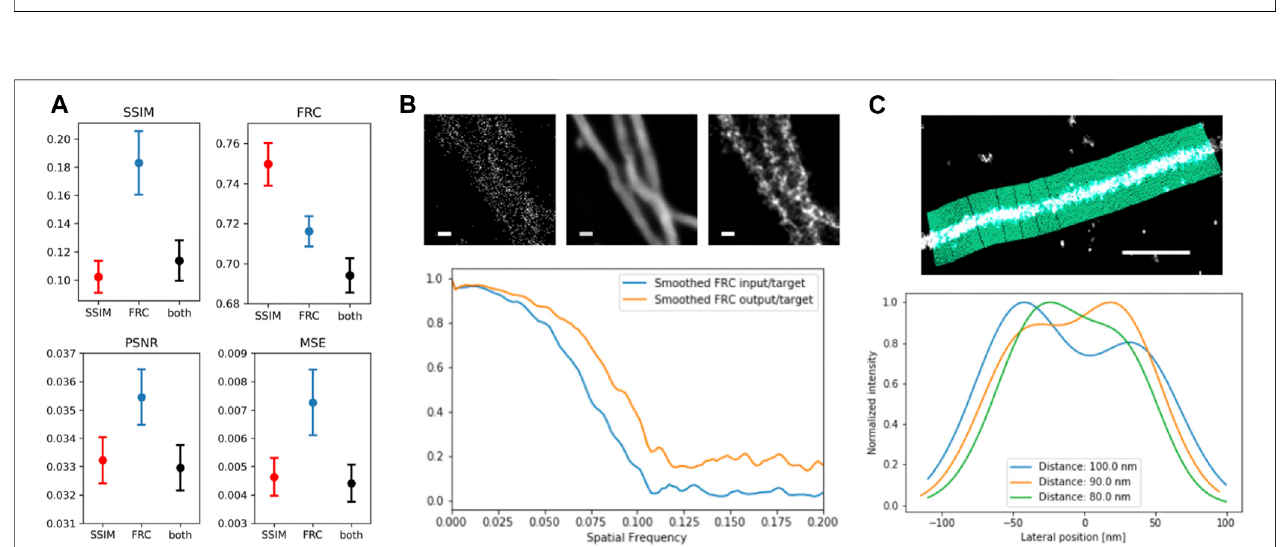
FIGURE4| Evaluationoftrainednetworks. (A) averagedMS-SIMandFRC(top),aswellaspeaksignal-to-noiseratio(PSNR)andmeansquarederror(MSE)for20 networkoutputandtargetimagesfromthevalidationdataset;errorbarsdenoteSEM. (B) FRCimprovementasfunctionofspatialfrequencyofinput(left)vs.target(right) andoutput(center)vs.target.Scalebar (cid:2) 100 nm. (C) LinePro fi lerevaluationillustratedatthetopandappliedtotwoadjacentsimulated fi lamentswithdistanceof80 nm (green), 90 nm (yellow) and 100 nm (blue), showing the emergence of two separate